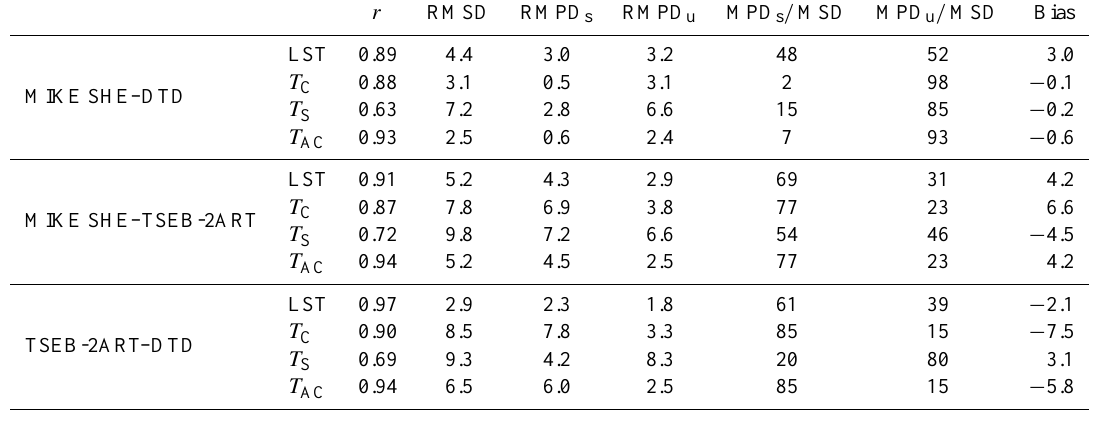
Table 6. Statistical comparison between MIKE SHE, DTD and TSEB-2ART models for the land surface temperatures (LST), canopy tem- peratures ( T C ), soil temperatures ( T S ) and in-canopy air temperatures ( T AC ). Statistics used: correlation coefficient ( r ), root mean square difference (RMSD), systematic and unsystematic root mean product differences (RMPD s and RMPD u respectively), the percentage of mean square difference (MSD) attributed to systematic and unsystematic mean product differences (MPD) (MPD s / MSD and MPD u / MSD re- spectively) and bias. LST comes from Aqua MODIS observations in the case of DTD and nadir view Envisat AATSR observations in the case of TSEB-2ART, and is modelled in the case of MIKE SHE. The other temperatures are estimated by all models. The statistics are in ◦ C, with the exception of MPD s / MSD and MPD u / MSD, which are percentages.